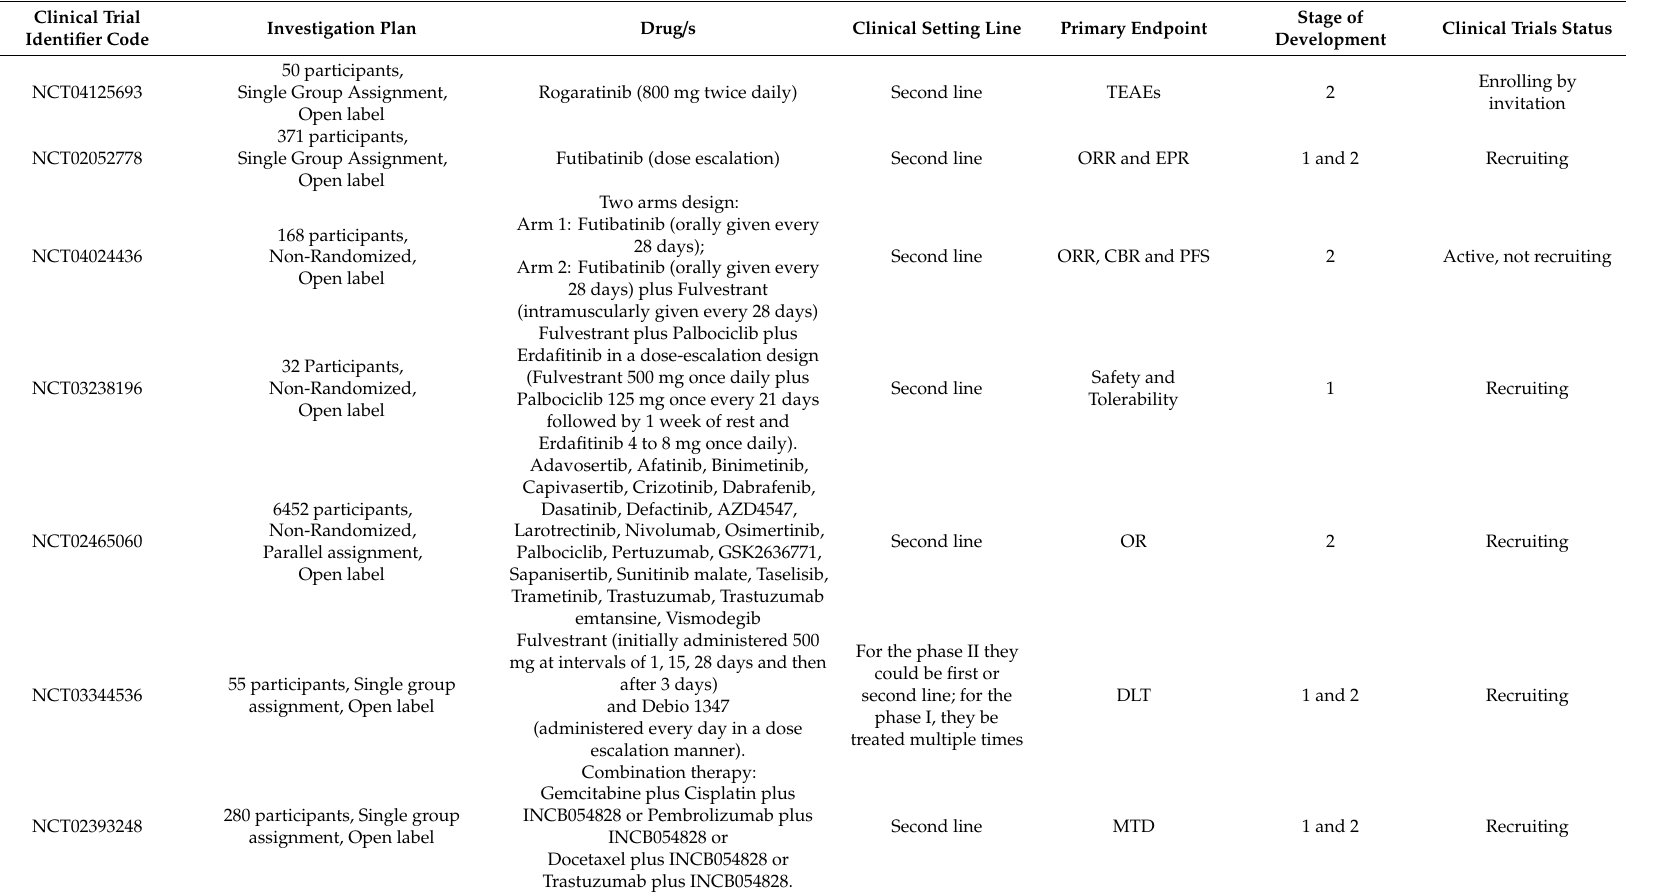
Table 1. Ongoing clinical trials investigating anti-FGFRs in the breast cancer